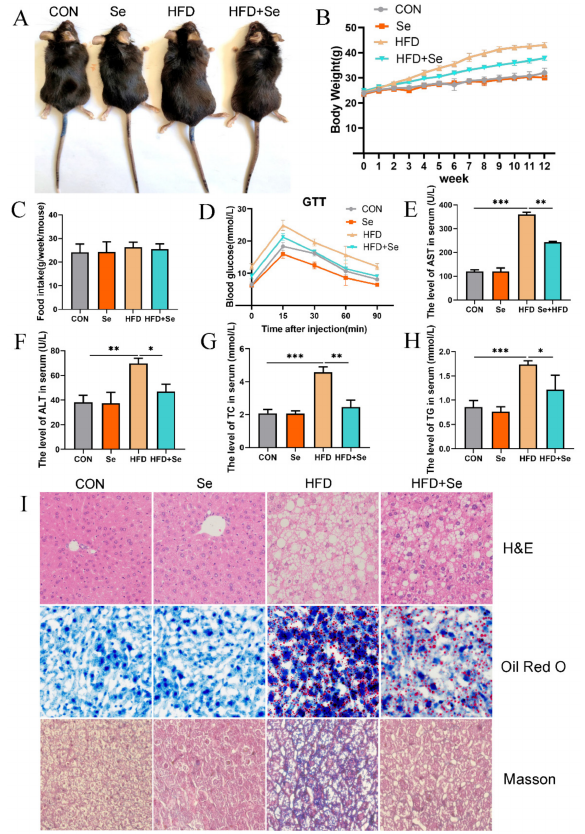
Figure 1. Effect of dietary selenium on hepatic injury and insulin resistance in HFD-induced NAFLD mice. ( A ) The appearances of C57BL/6 J mice in different groups were photographed in the last week. ( B ) The body weights of mice were monitored for 12 weeks. ( C ) Food intake was monitored every week. ( D ) The results of IPGTT. ( E ) The levels of serum AST ( n = 6, *** p < 0.001, ** p < 0.01). ( F ) The levels of serum ALT ( n = 6, ** p < 0.01, * p < 0.05). ( G ) The levels of serum TC ( n = 6, ** p < 0.01, *** p < 0.001). ( H ) The levels of serum TG ( n = 6, * p < 0.05, *** p < 0.001). ( I ) H&E staining, Oil Red O staining, and Masson staining of liver section (400 ×